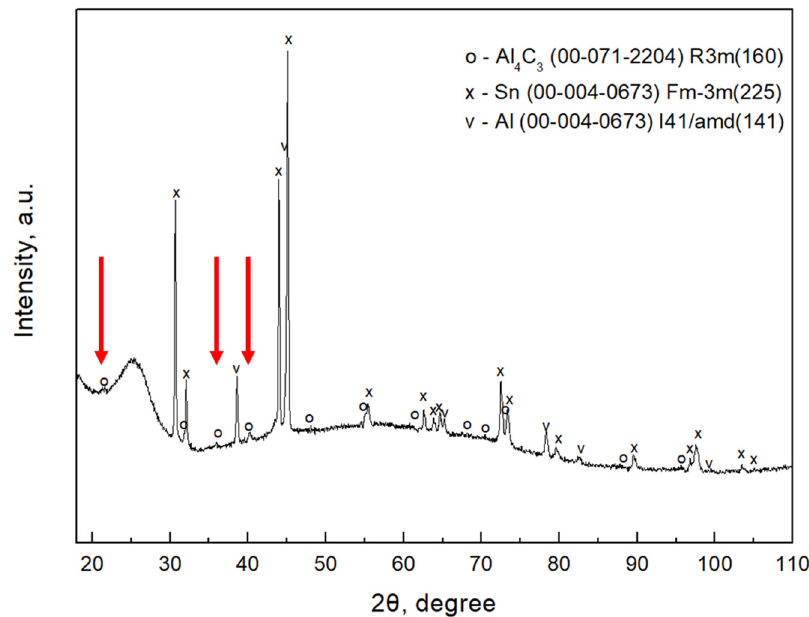
Figure 5. X-ray diffraction pattern of the fiber extracted from the composite after heat treatment at 600 °C.